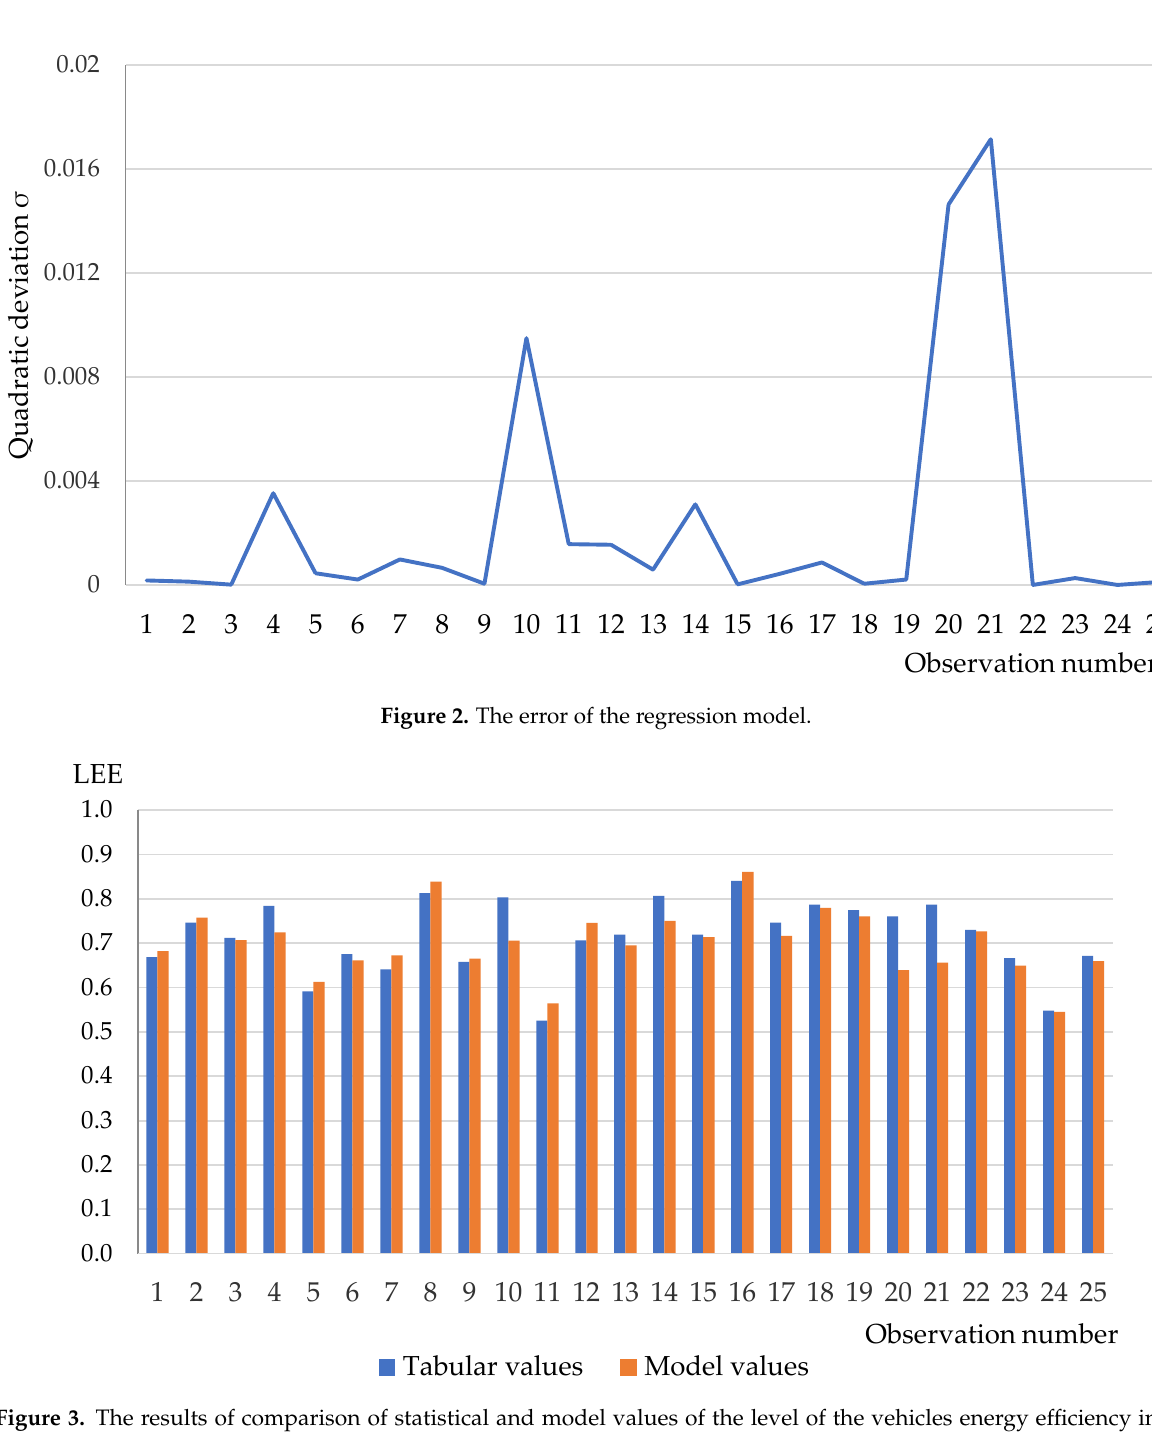
Figure 3. The results of comparison of statistical and model values of the level of the vehicles energy efficiency in the training sample.